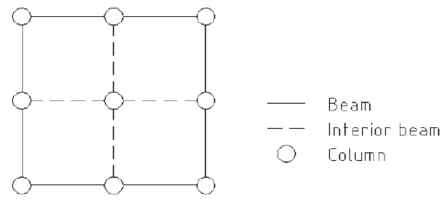
Figure 1. Planview of a frame system. Source: [12].